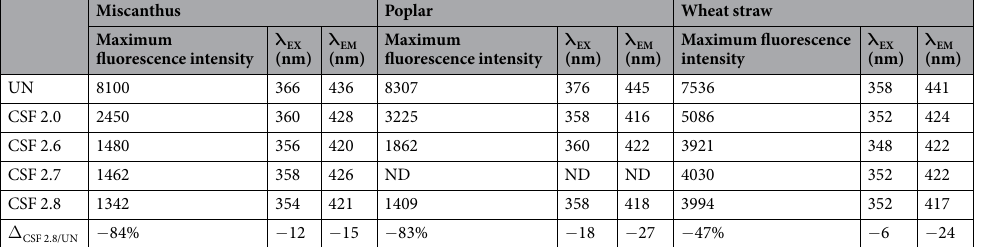
Table 2. Maximum fluorescence intensity and corresponding excitation ( λ EX ) and emission ( λ EM ) wavelengths of untreated (UN) and pretreated samples from Fig. 1 and Supplementary Figs 1 and 2. Standard deviations from fluorescence intensity measurements done in triplicate are below 5%. Δ CSF 2.8/UN : variation between pretreated sample with CSF 2.8 and untreated sample.